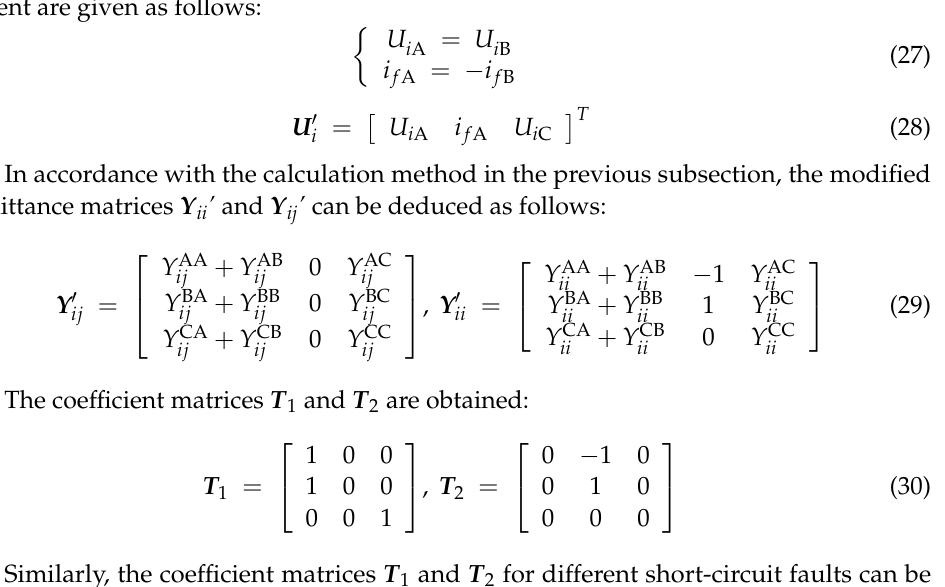
Table 1. The coefficient matrices for different short-circuit faults. Faults U i ’ T 1 T 2 Phase-A-to-ground fault